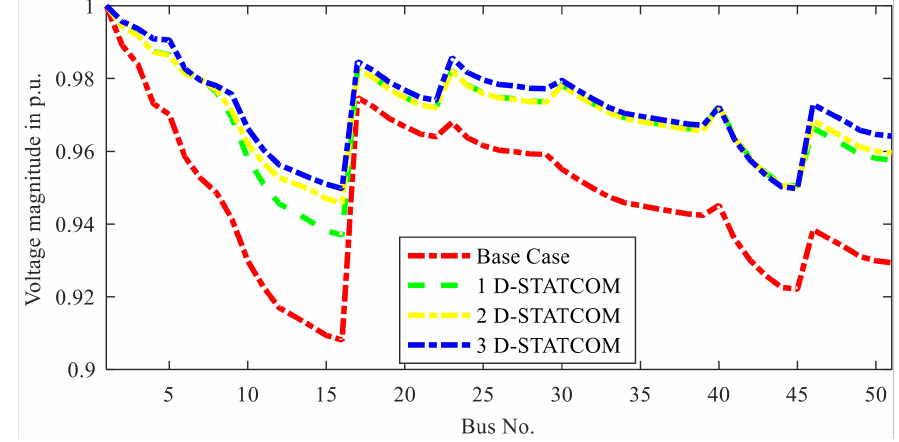
Figure 16. Comparison of voltage profile with and without D-STATCOMs of 51-bus PDN.